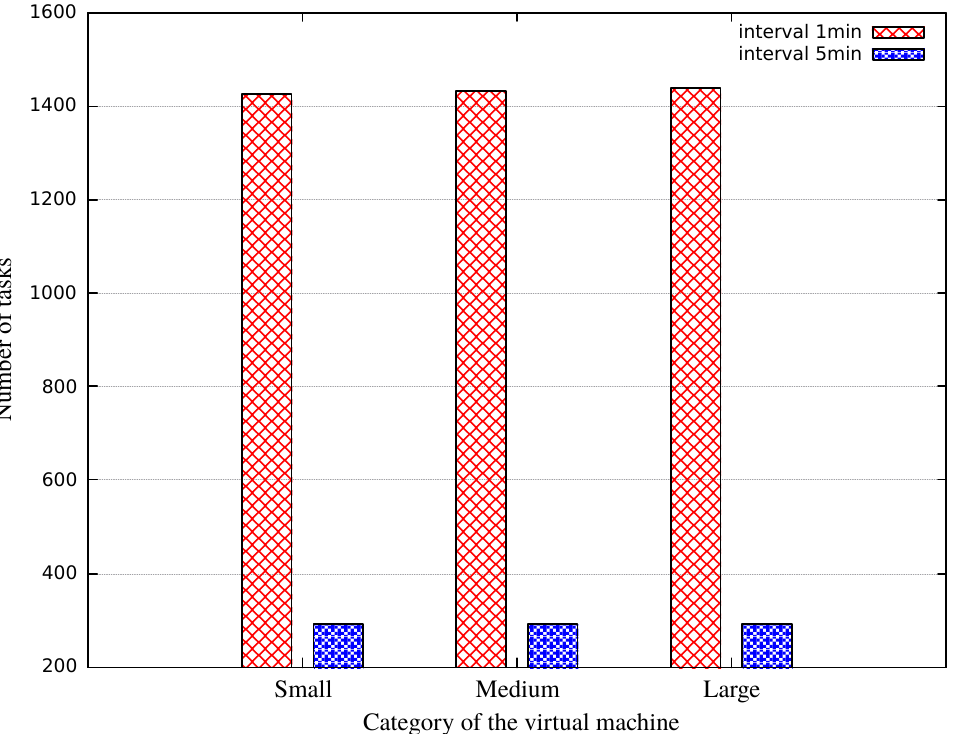
Figure 13. Number of tasks over time in scenario N o